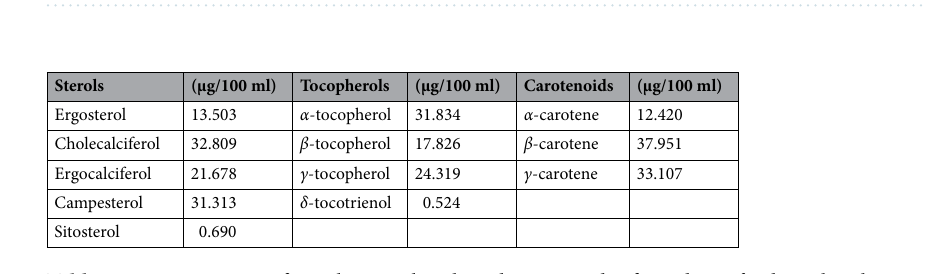
Table 4. Concentration of sterols, tocopherols and carotenoids of C. schweinfurthii pulp